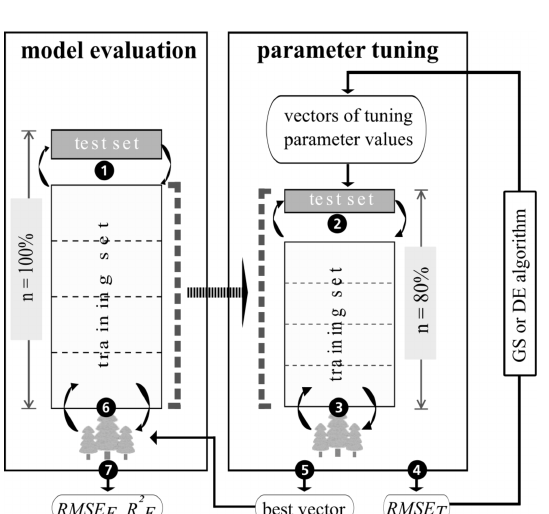
Figure 3. Nested cross-validation approach comprising model evaluation and parameter tuning. Adapted from Guio Blanco et al. (2018). The tree icons symbolize BRT models, which are re- peatedly (circular arrows) trained and tested on different data sets. The numbers within black circles refer to the steps described in Sect. 2.5. “RMSE T ” is the root-mean-squared error of parameter tuning, “RMSE E ” is the root-mean-squared error of model evalua- tion, “ R 2 ” is the coefficient of determination of model evaluation, E “GS” refers to grid search, and “DE” refers to the differential evo- lution.